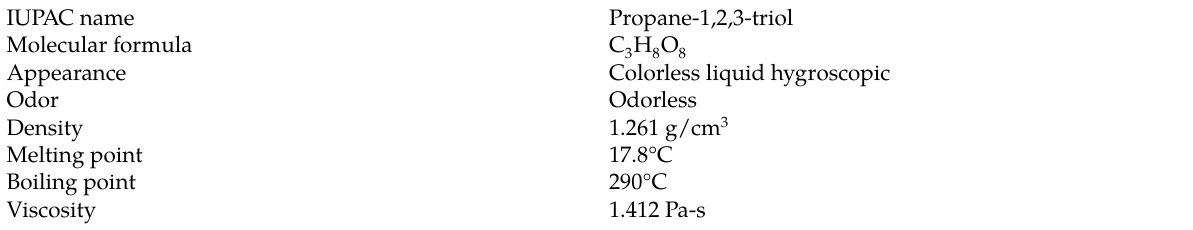
Table 3: Properties of glycerol [bib, https://en.wikipedia.org/wiki/Glycerol].